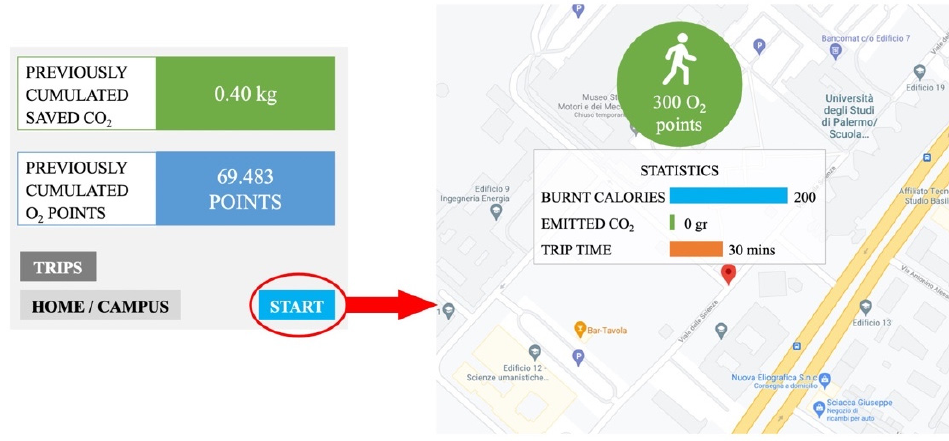
Figure 3. Mobile-phone screenshots of the app shown to the commuter users. The proposed reward scheme was field-tested by using a sample of commuter stu- dents. The new mobility percentages, MS’ , by distances and transportation modalities that emerged from testing the selected sample of students (Table 5) were attributed to the totality of the commuters gravitating around the campus in order to assess the whole energy and environmental benefits if they all chose to apply to the program. Table 5. SCENARIO 1 —share of commuters by zone and modality ( MS’ zm ) and related numbers ( NC’ zm ) per zone and per